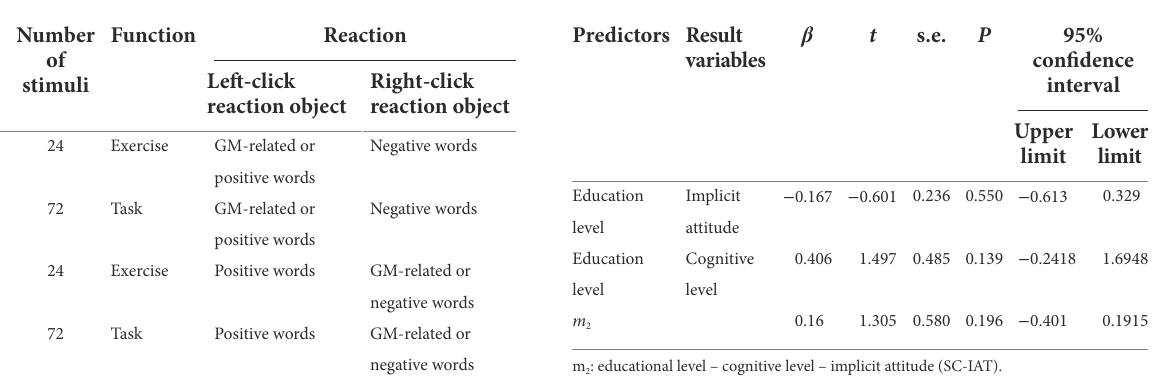
TABLE 3 SC-IAT experimental